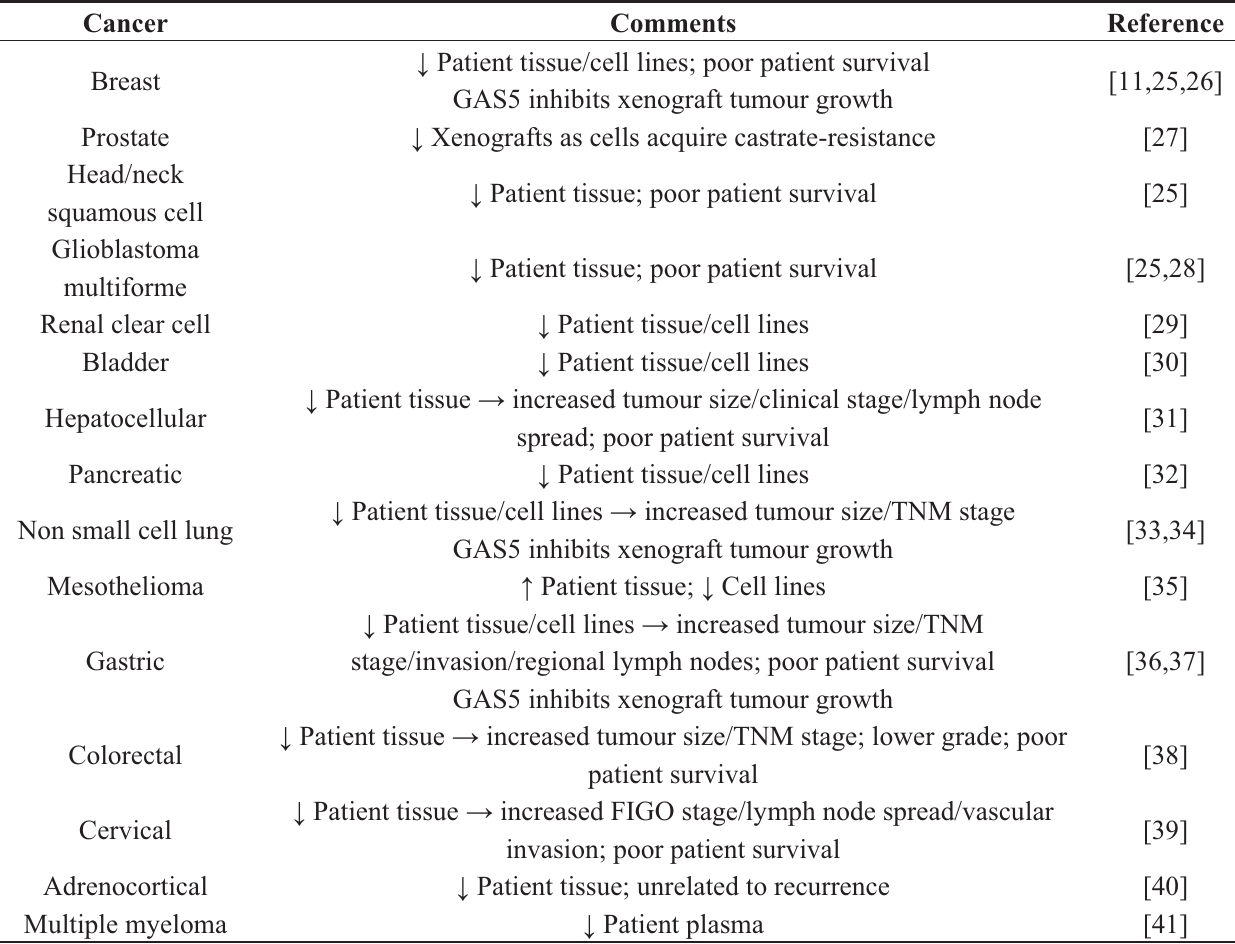
Table 1. GAS5 expression in human cancer . ↓ and ↑ = down - and up-regulated expression, respectively, in the indicated cancer tissues/model systems; → = leading to; TNM = cancer staging system of the International Union for Cancer Control (UICC) which takes into account the primary tumour (T), lymph nodes (N) and metastases (M) — a higher stage indicates a more advanced cancer; FIGO = comparable staging system of the International Federation of Gynecologists and Obstetricians (FIGO) for cancers of the female reproductive